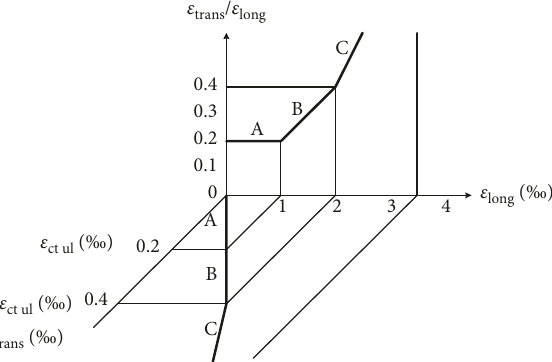
Figure 8: Theoretical dependences between transverse de- formations vs. longitudinal deformations and transverse to lon- gitudinal deformations’ ratio vs. longitudinal deformations: A, linear behavior of HSC; B, nonlinear behavior of HSC; C, stage before the HSC reaches the